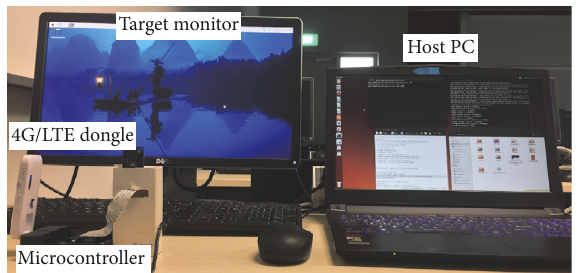
Figure 4: Overview of fouling image recognition system setup includes microprocessor connected via mobile connection (left) and host device (right) in laboratory.